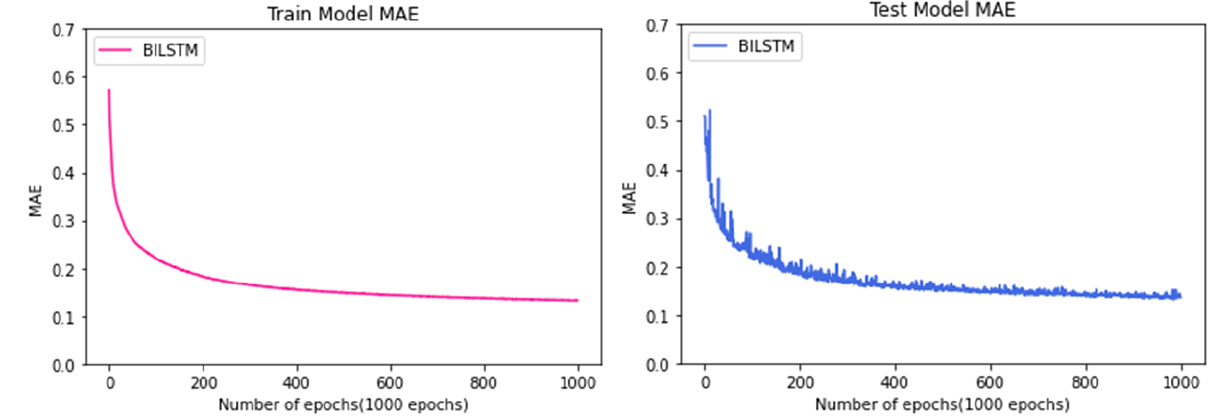
Figure 13. Comparison between train data and test data of the model using the BI-LSTM algorithm.